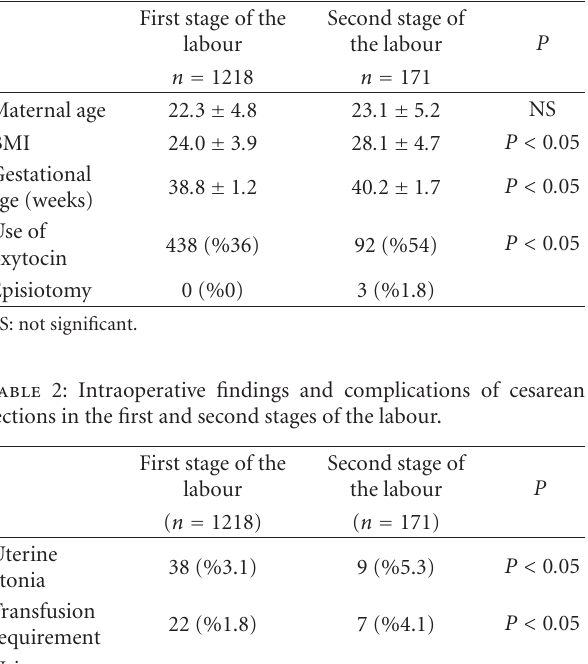
Table 1: Patient characteristics.